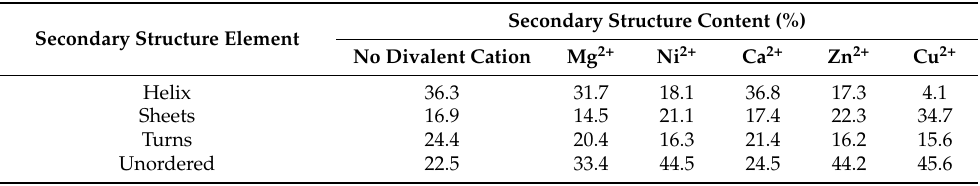
Table 2. Influence of divalent cations on the secondary structure of